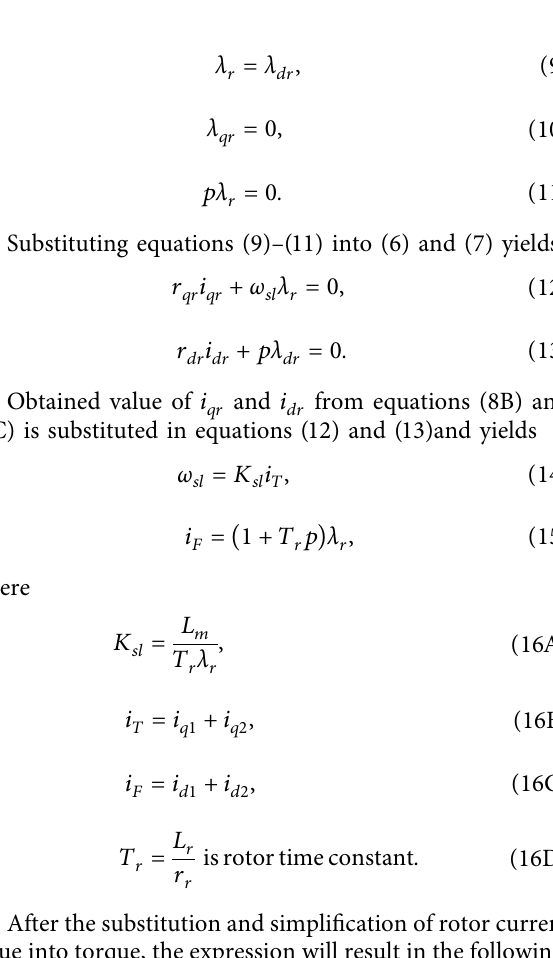
Figure 1: Open-ended winding asymmetrical six-phase induction motor connected to inverter